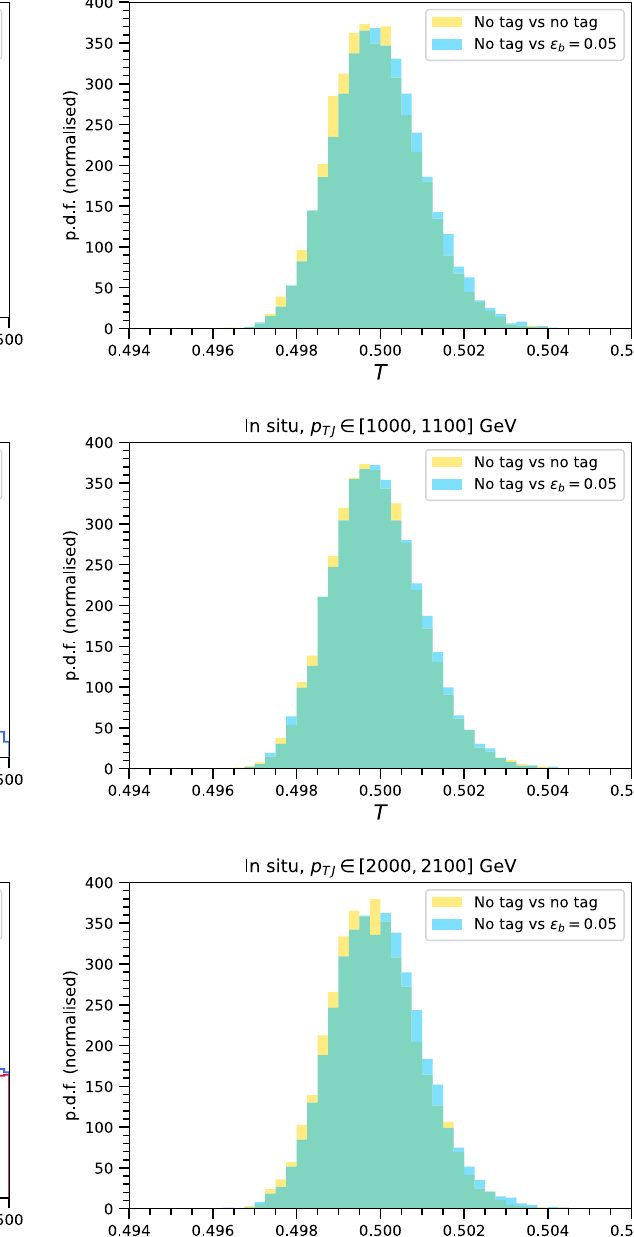
functions for the estimator T , obtained when the two samples are drawn from the untagged jet pool (yellow) or from the untagged and tagged jet pools